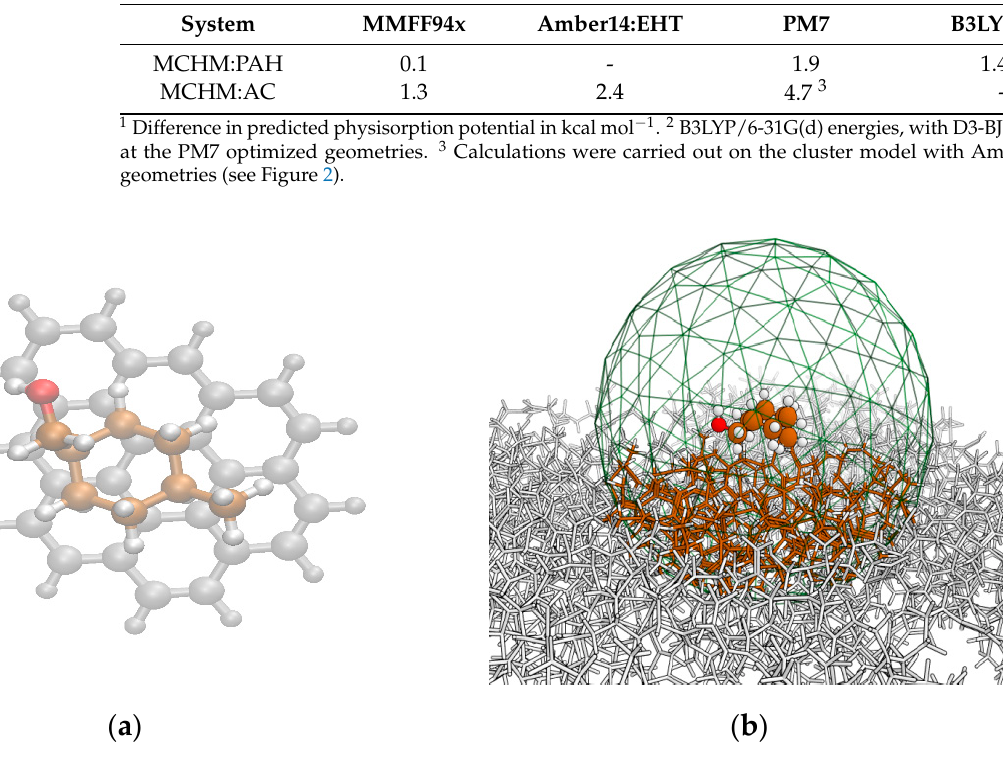
Figure 2. Planar and amorphous carbon surface models used in this study. ( a ) Starting structure of cis -MCHM on ovalene PAH. In this view, it can be seen that the ovalene is just large enough to accommodate the maximum footprint of the MCHM molecule. ( b ) Minimum structure of cis -MCHM adsorption site on an amorphous carbon surface. The green mesh indicates the 12 Å boundary for building the cluster model. Atoms (colored) within the mesh are subject to higher level computation using the PM7 semi-empirical method (see details in Section 4.1.3 of the text).